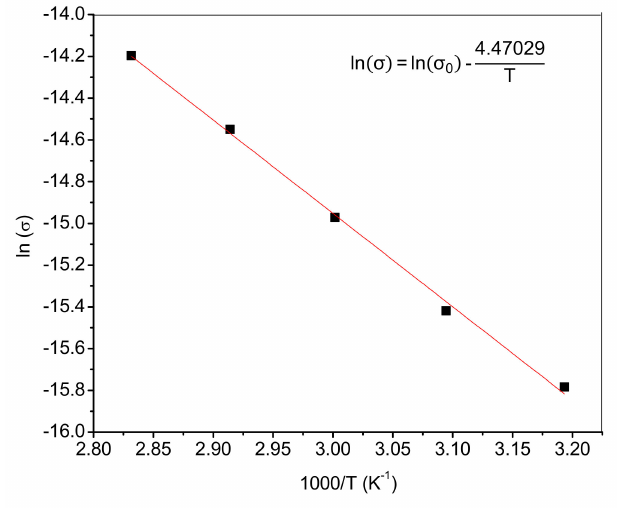
Figure A2. Arrhenius plot for the sIPN 143,5 -SPSU